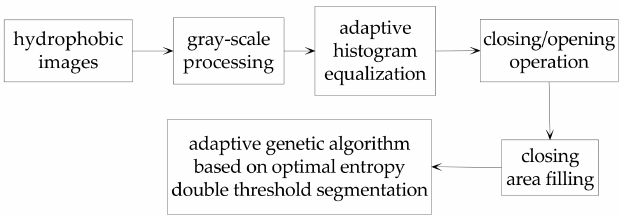
Figure 4. Flow chart of the processing of hydrophobic images.